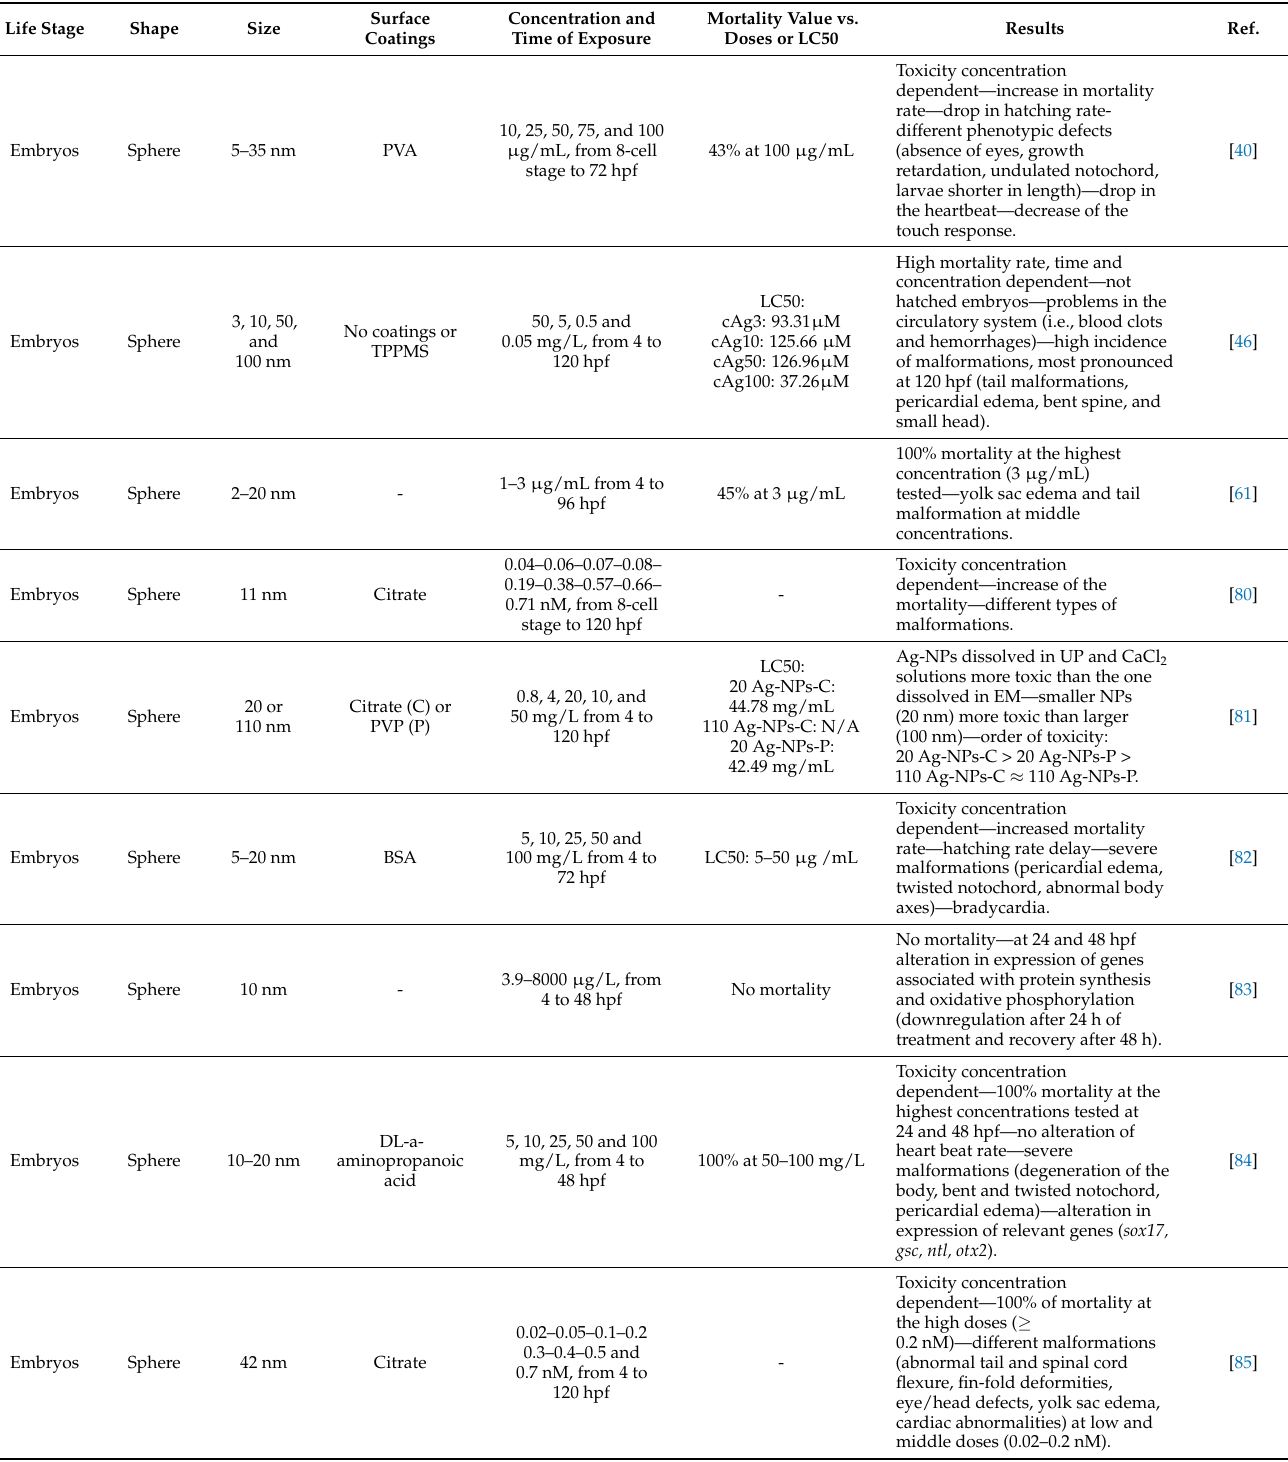
Table 2. Effects of silver nanoparticle with different size and surface coatings in